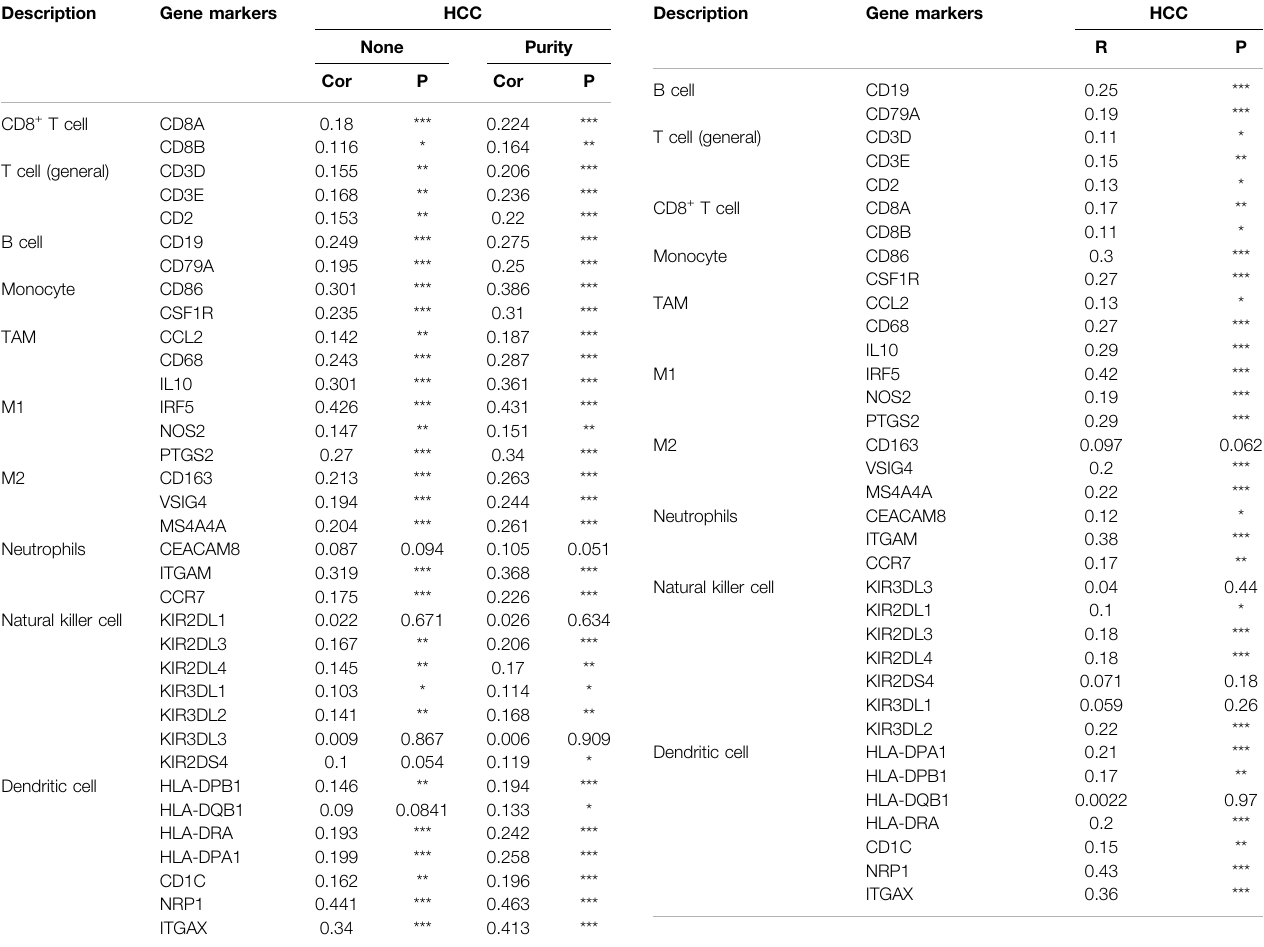
TABLE 1 | Correlation analysis between HSF2 expression and gene markers of immune cells using TIMER. Description Gene markers